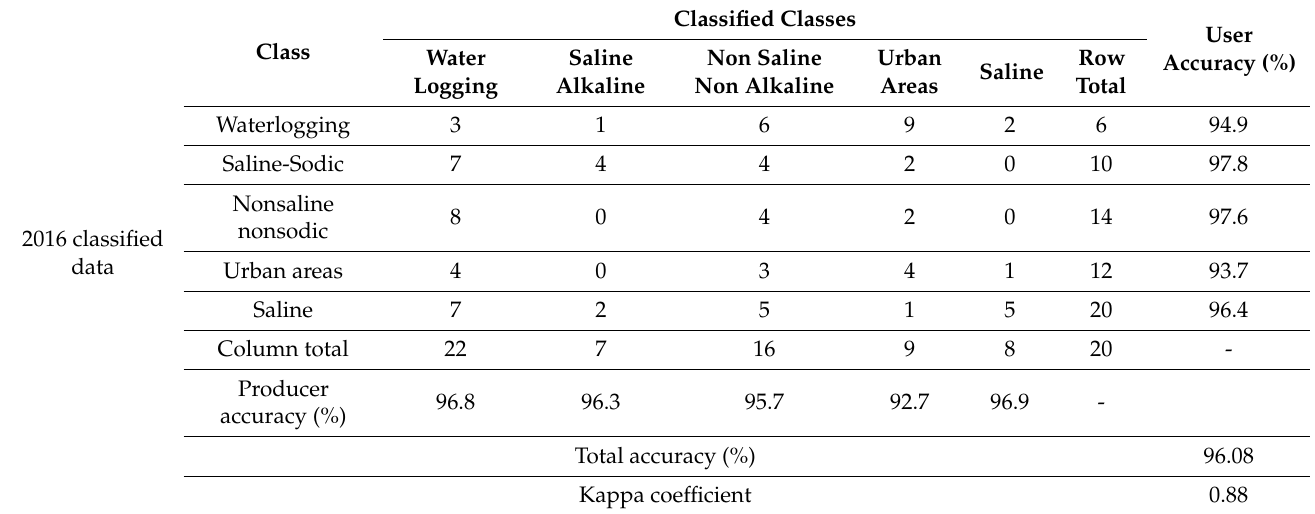
Table 6. Accuracy assessment using error matrix in 2016 based on soil survey of 20 soil profiles.